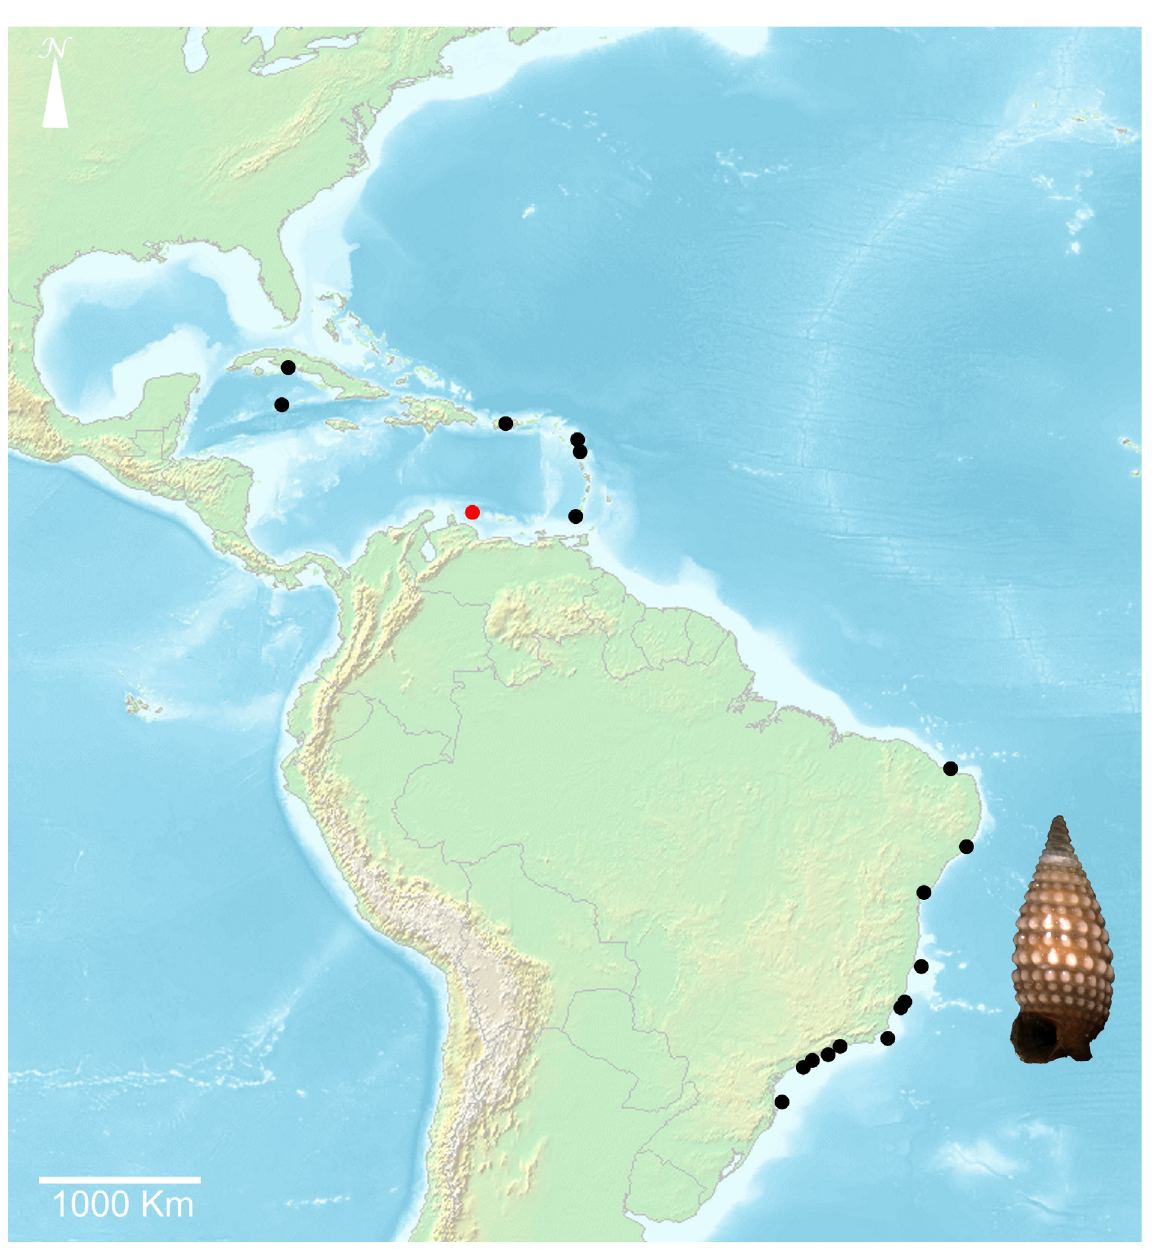
Fig. 59. Distribution map of Nanaphora verbernei (Moolenbeek & Faber, 1989); red circle = type